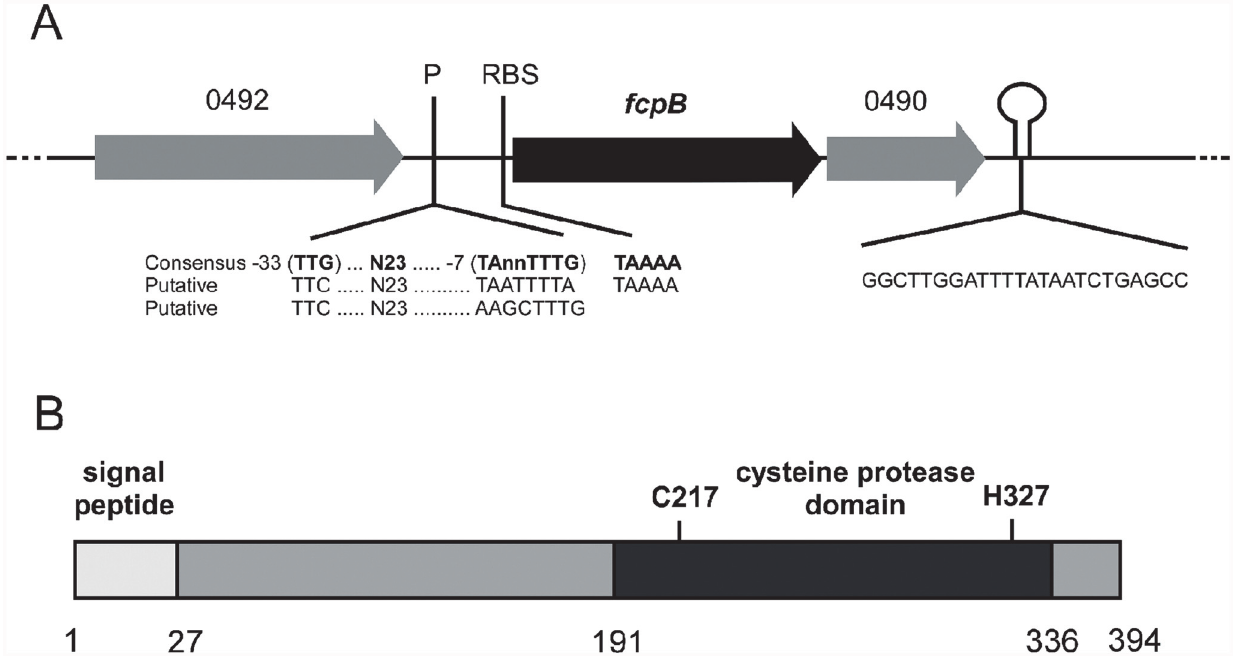
Fig 1. fcpB locus and FcpB predicted structure. (A) Gene organization of the fcpB locus in the F. psychrophilum genome . The position of each gene and the direction of the transcription are shown by arrows. The putative fcpB promoters (P), ribosomal binding site (RBS), and rho-independent transcriptional terminator (hairpin loop), together with the corresponding sequences, are showed. The flanking genes 0492 (encoding a putative transmembrane protein) and 0490 (encoding a putative lipoprotein precursor) are indicated. (B) Structural organization and predicted domains of the FcpB cystein peptidase. Domain regions are dark grey and the position of the initial and final residues of each domain are indicated below. The amino acids corresponding to the active site are indicated in bold.